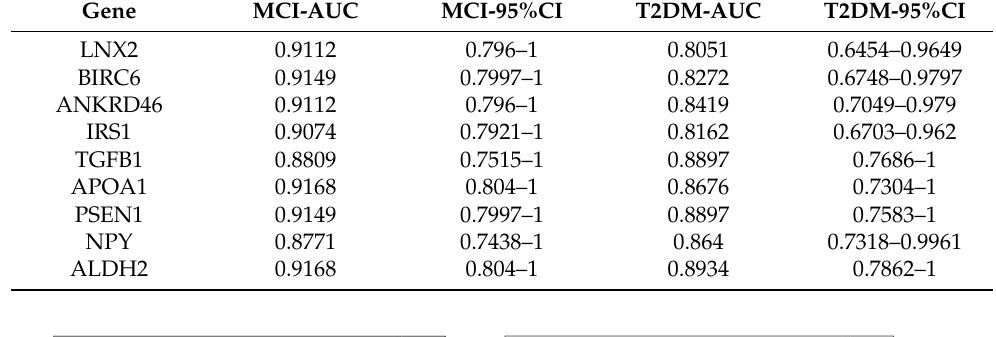
Table 3. Diagnostic value of hub genes in MCI and T2DM.